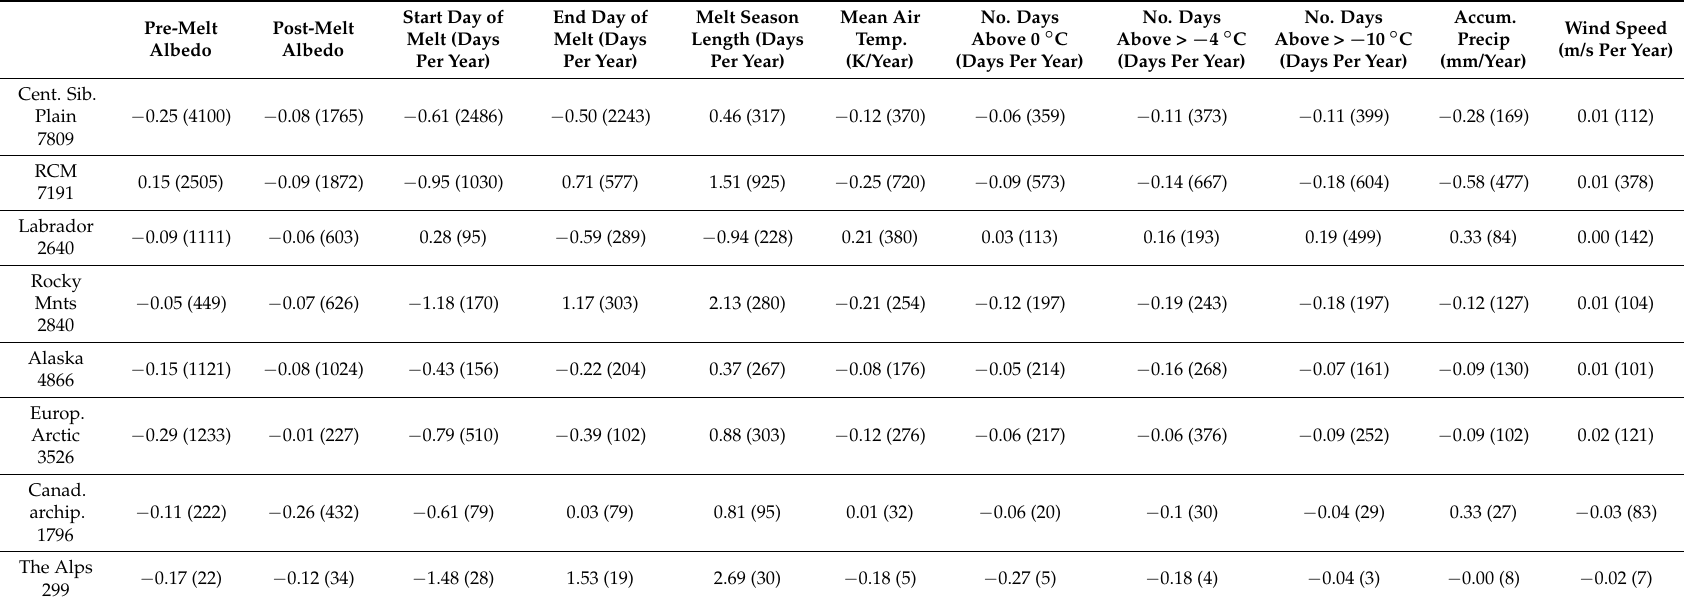
Table 2. The mean trends ( R 2 > 0.5) for all the melt season and climatic parameters in areas with observed consistently homogenous change. The trends for snowfall and rain were not included in the table due to the fact that the trends for the pre-defined regions presented in the table were so weak that they were less than the yearly variation of the parameter. All climate parameters are derived for 14 days preceding the onset of snow melt. The number of observations in the area are described in the parenthesis. The area “RCM” refers to the area around the border of Russia, China and Mongolia. The negative trends for the melt season timing mean earlier onset or end of melt and shorter melt season and the positive trend directions mean later onset and end of melt and longer melt